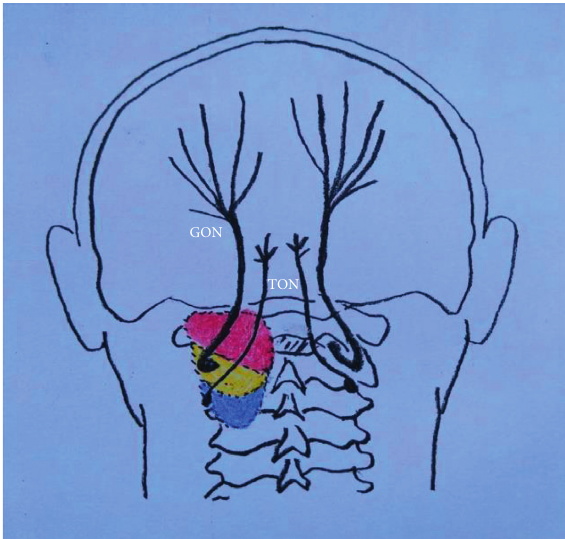
Figure 1: A schematic diagram demonstrating the extent of dye spread between different injectate volumes. The red area indicates the distribution of 2ml injectate volume. The red and yellow areas denote the distribution of 3.5ml injectate volume. The red, yellow, and blue areas show the distribution of 5 ml injectate volume. GON: greater occipital nerve; TON: third occipital nerve.